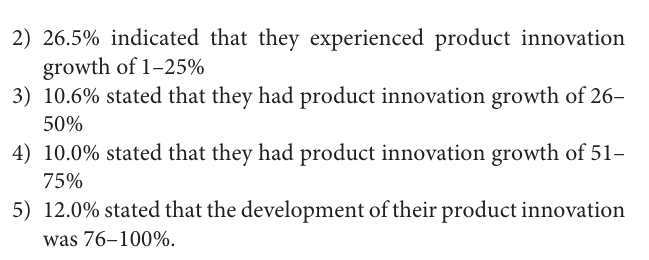
TABLE 3 | Reliability test result. IIE EES SEO SEI SEA Cronbach’s